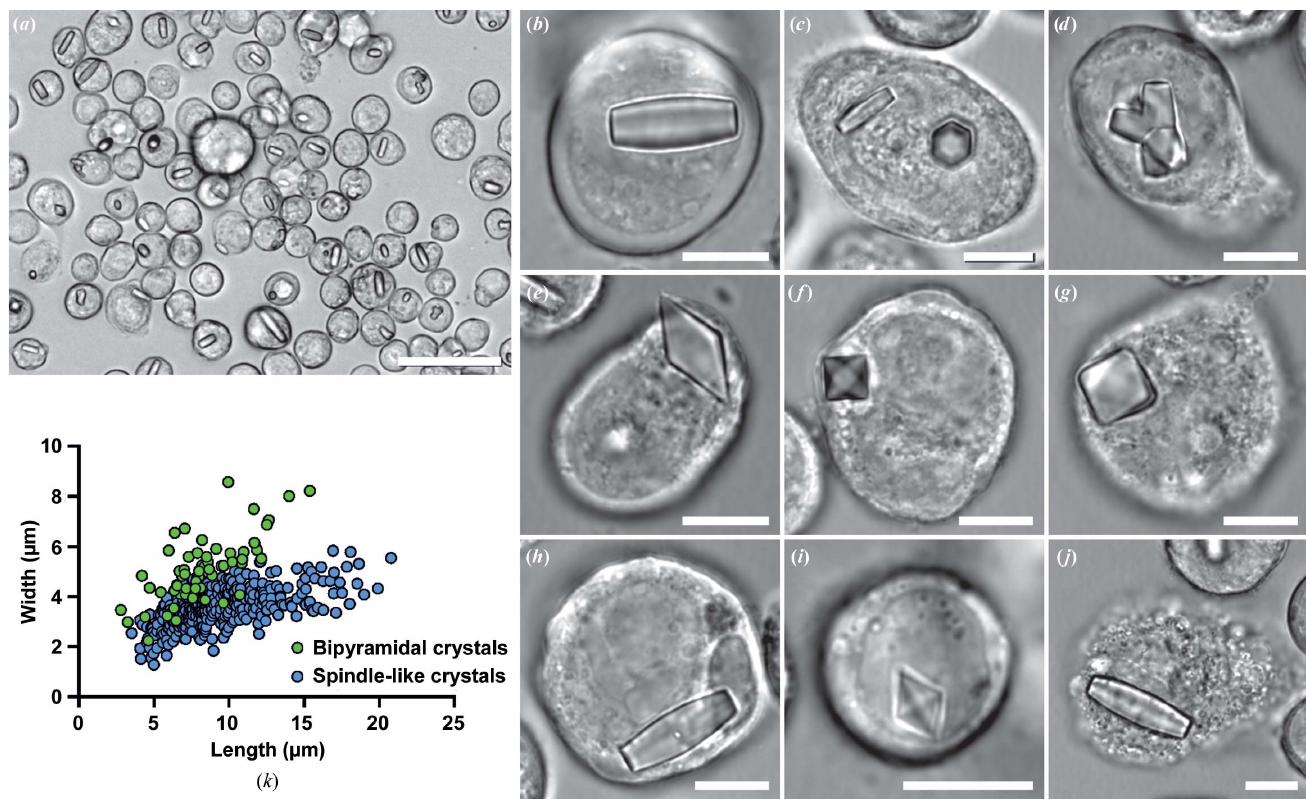
Figure 1 Crystallization of HEX-1 from N. crassa in living insect cells. Light-microscopic images of Sf9 cells four days after infection with a recombinant baculovirus encoding the target protein (MOI = 1). Most cells produce a single crystal per cell ( a ). Two different crystal morphologies can appear. The first is a spindle-like morphology with flat ends and a slightly increased diameter in the middle ( b ) showing a hexagonal cross section ( c ). These crystals sometimes grow in a star-like manner, conjoined in the middle ( d ). The second morphology is bipyramidal ( e ) with pointed tips and a square base ( f ). These crystals can sometimes form somewhat irregular forms with rounded tips ( g ). Both morphologies can grow cytoplasmatically as well as within the cell nucleus [( b ) versus ( h ) and ( e ) versus ( i )]. After cell lysis the crystals show high stability in the cell-culture medium, while mostly sticking to cell remnants ( j ). Bipyramidal crystals constitute about 13% of the total crystal population. The size distribution shows that the bipyramidal crystals form shorter but broader crystals overall compared with the spindle-like crystals ( k ). Size bars: 50 m m ( a ), 10 m m ( b )–( j